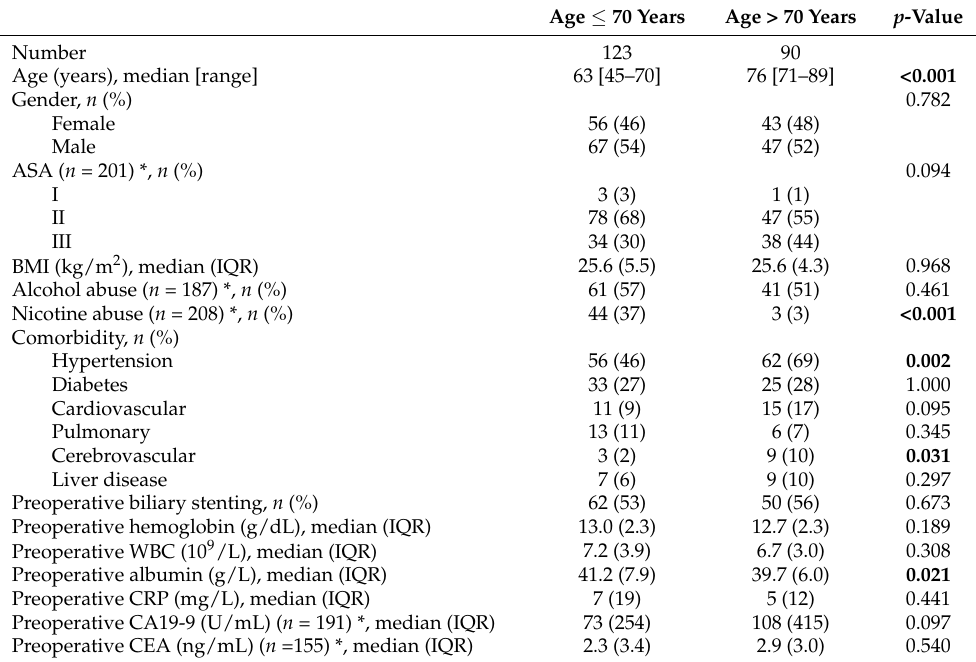
Table 1. Characteristics of patients undergoing pancreatic resection for pancreatic ductal adenocarci- noma stratified to age ( ≤ 70 years vs. >70